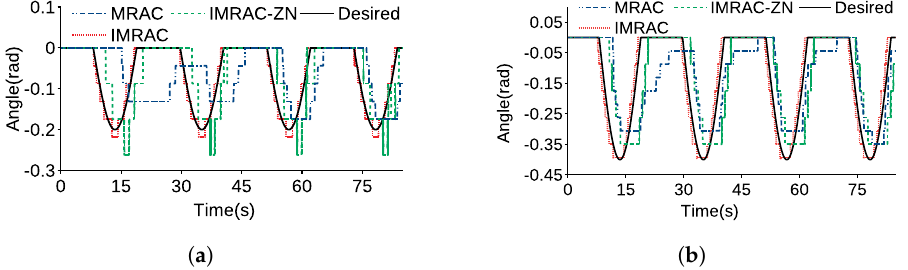
Figure 8. Comparisonof an angular trajectory for MRAC, IMRAC-ZN, and IMRAC. ( a ) Hip; ( b )